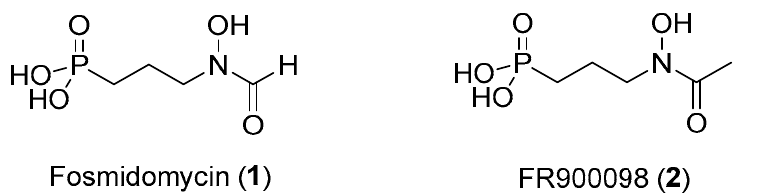
Figure 1. Structural formula of the natural product fosmidomycin ( 1 ) and its acetyl analog FR900098 ( 2 ).